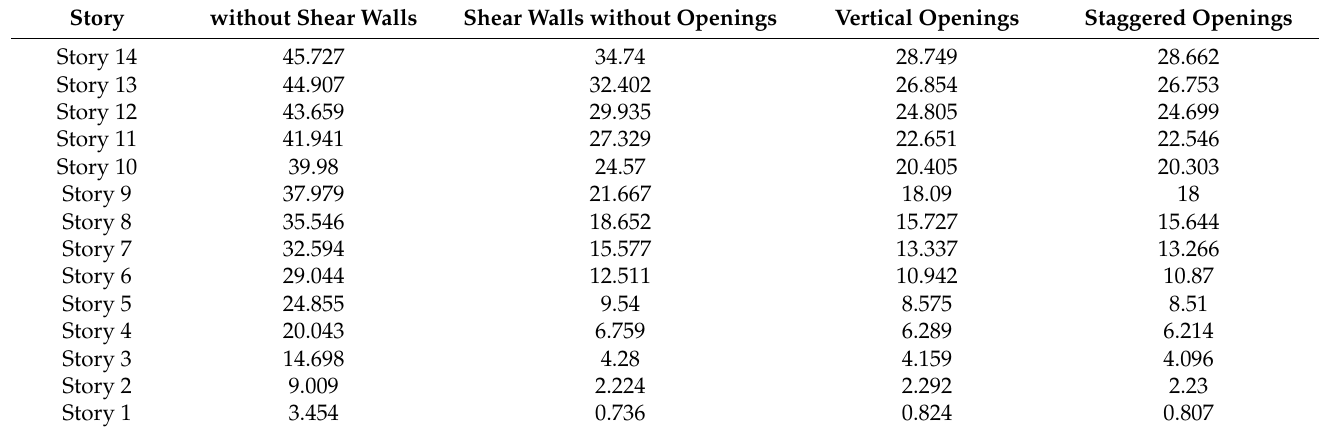
Table 8. Comparison of the story displacements, time history, and X-direction (mm).